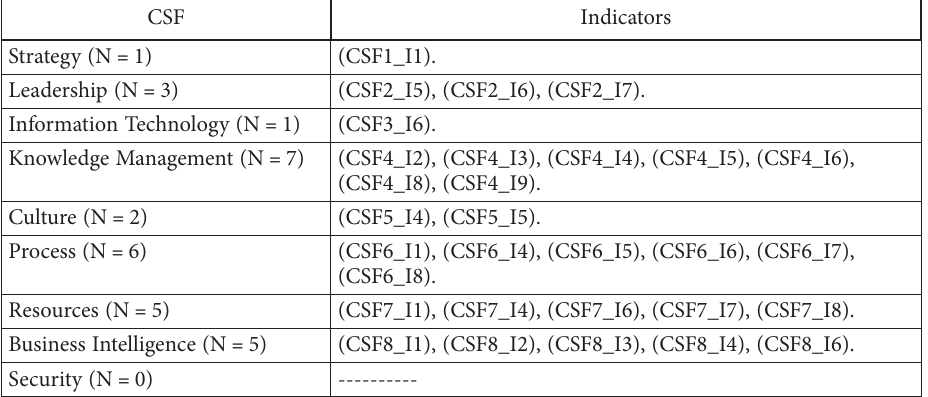
Table 9. The number of weak